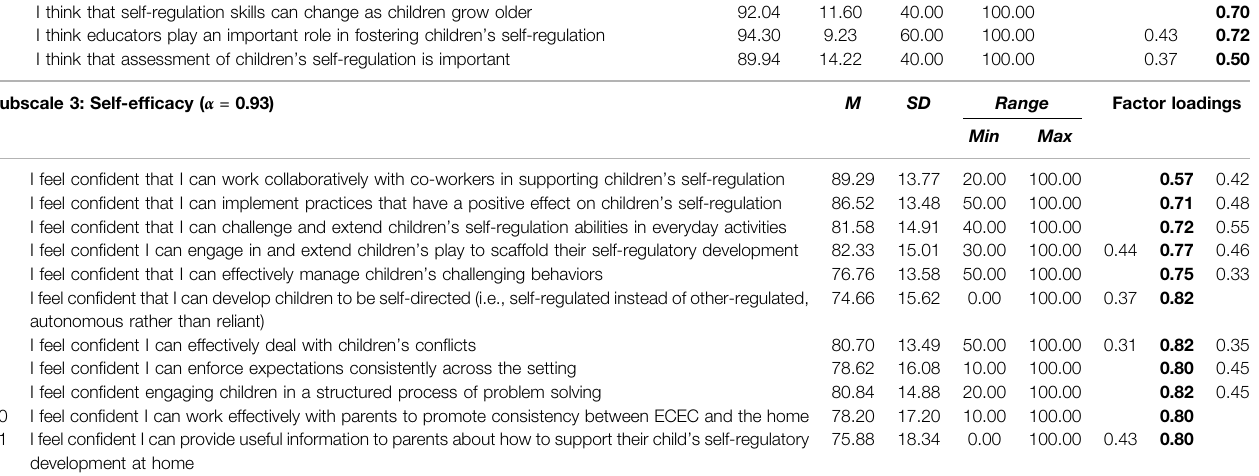
TABLE 2 | Fit of subscales to the Rasch Model.